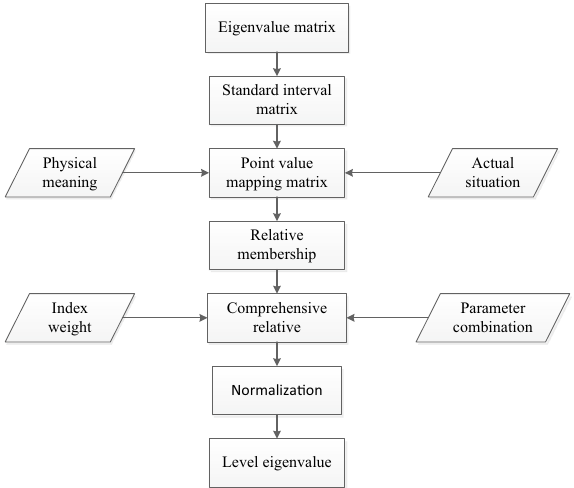
Figure 2. Variable fuzzy evaluation steps.